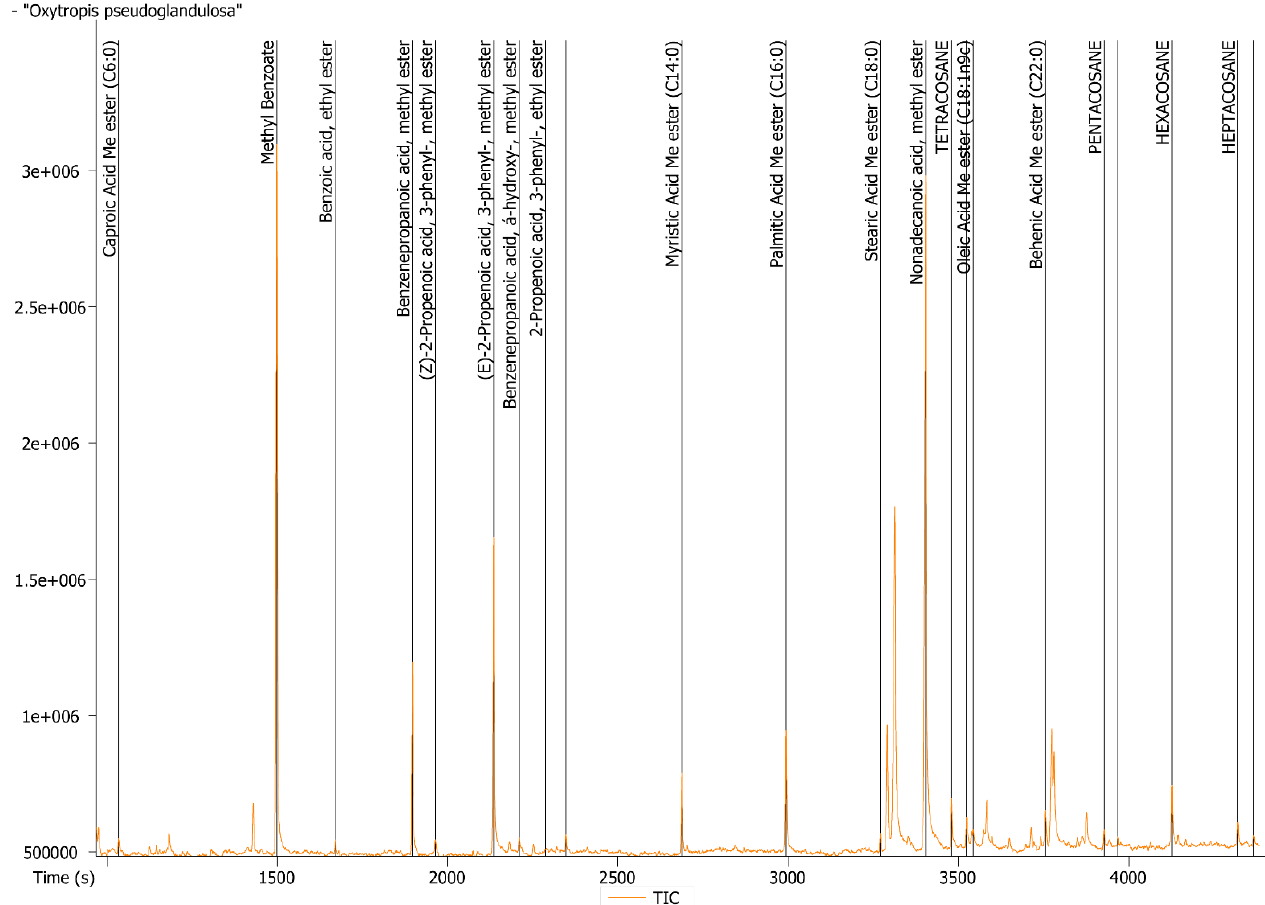
Figure 2. GC/MS analysis of O. pseudoglandulosa lipid composition. Table 2. Identification of lipid compounds in O. pseudoglandulosa.